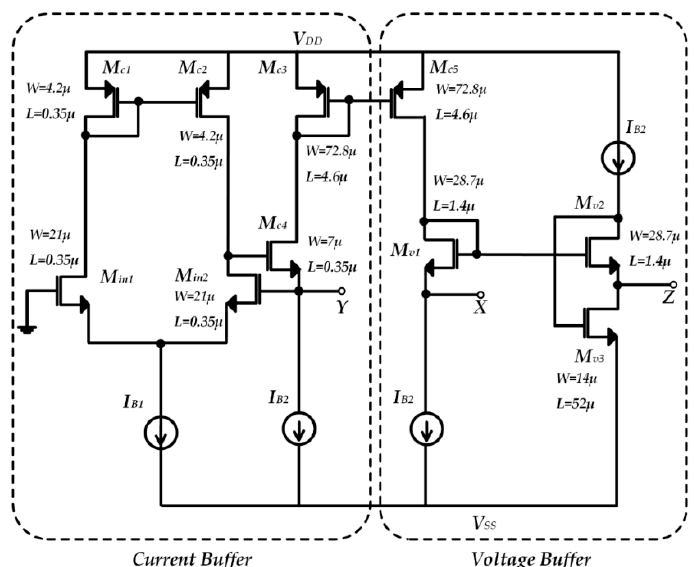
Figure 2. VCII transistor level implementation.